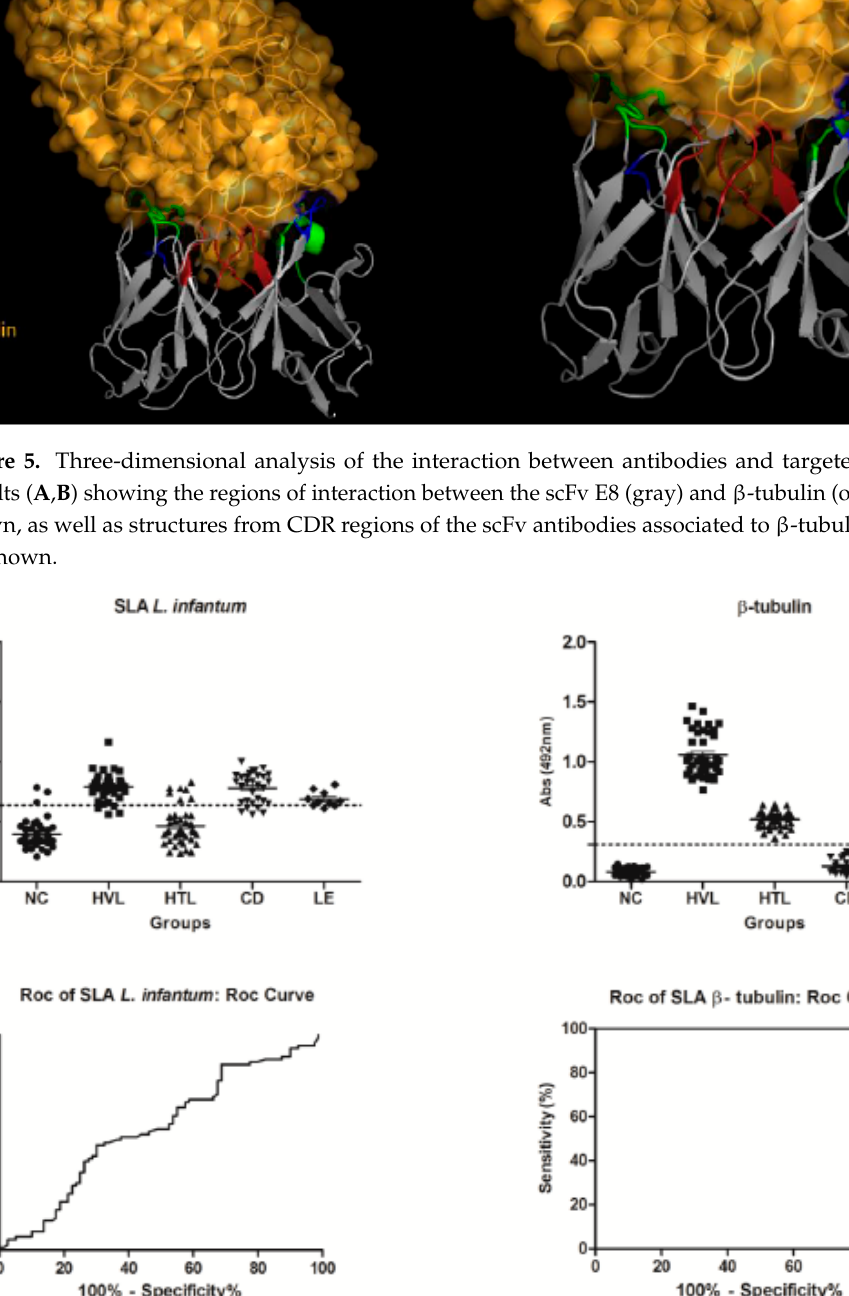
Figure 6. Serological reactivity of recombinant β -tubulin protein and L. infantum SLA in serum samples from patients and controls. ELISA assays using human serum samples from uninfected resident individuals in an endemic area of leishmaniasis (NC, n = 40), visceral leishmaniasis patients (HVL, n = 40), tegumentary leishmaniasis (HTL, n = 40), Chagas’ disease (CD, n = 30) and leprosy (LE, n = 10) were tested using total protein extract of L. infantum and the recombinant β -tubulin. In the x -axis we have the experimental groups of the patients and in the y -axis the absorbance (492) nm of the samples in the ELISA.